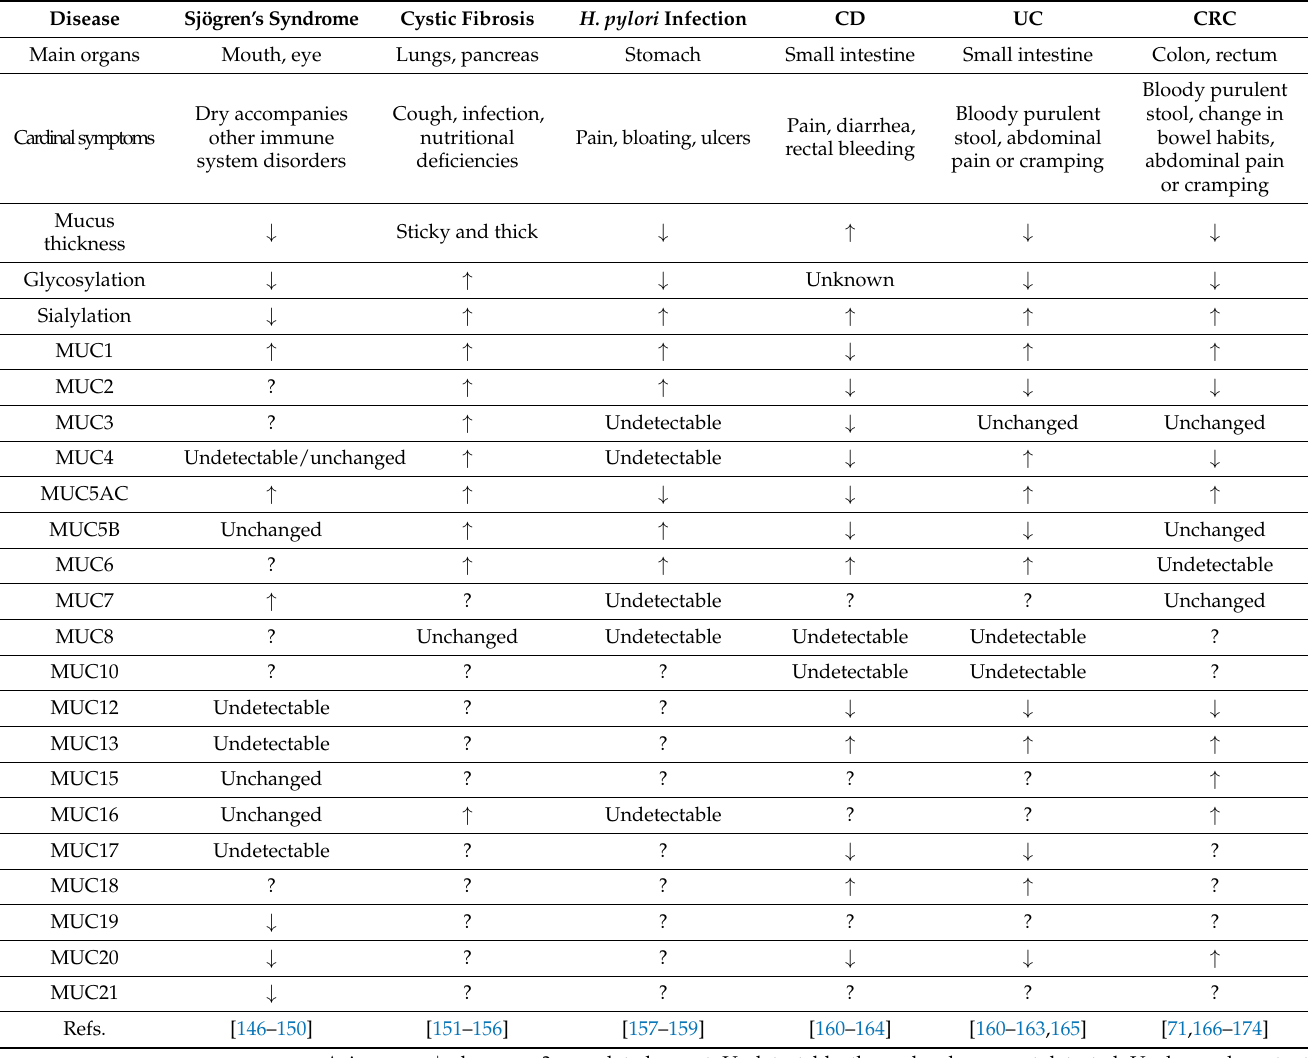
Table 3. Illustration of mucin-related